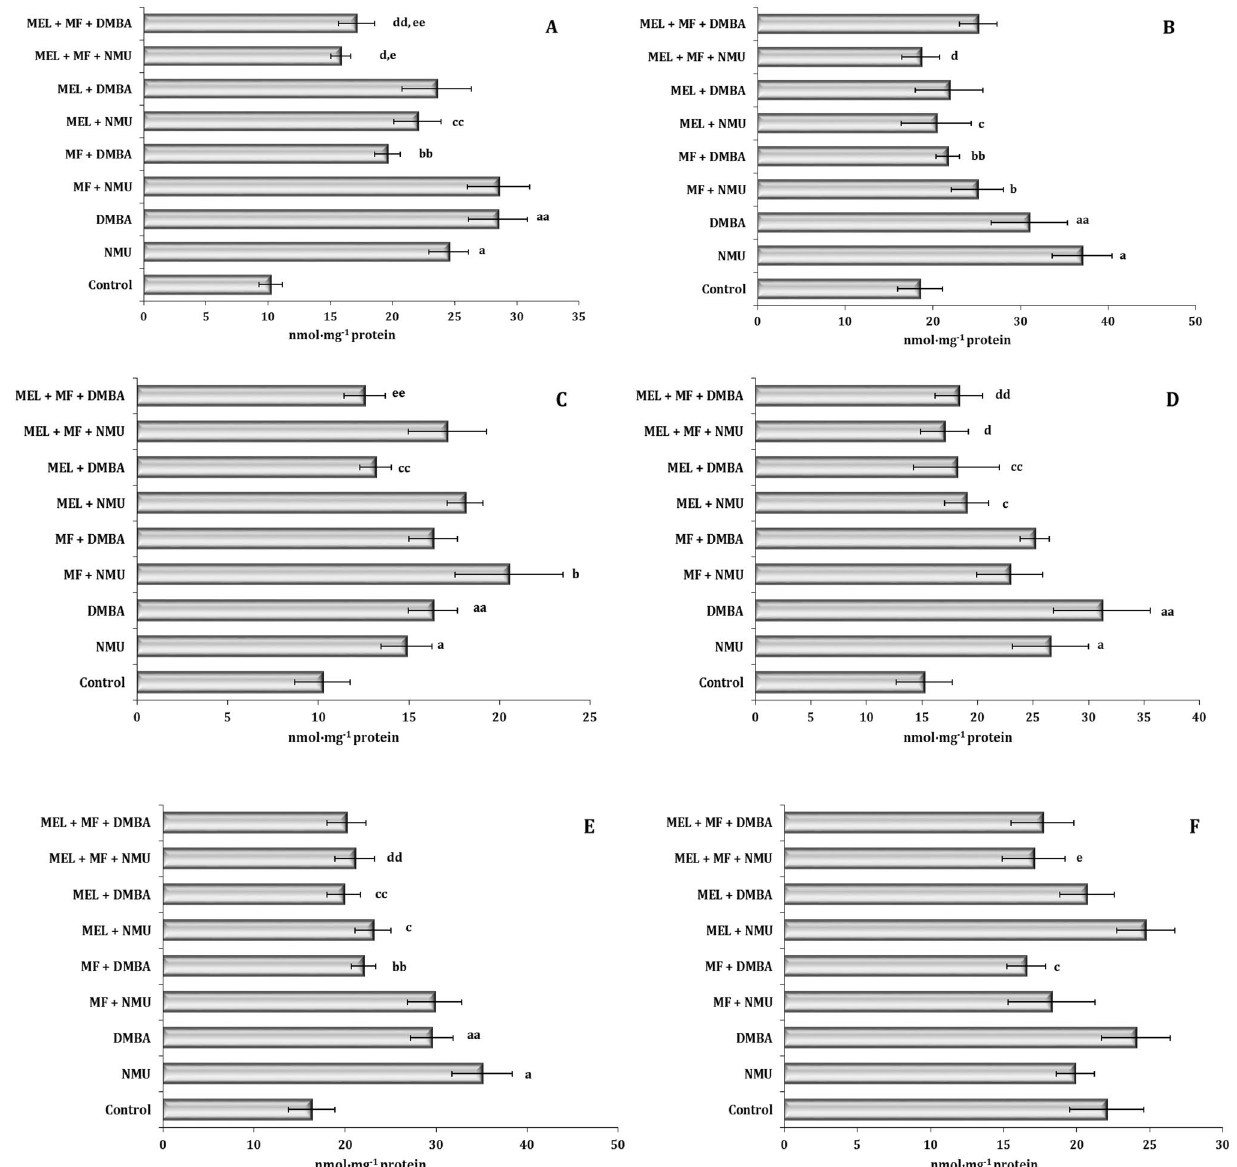
Figure 1. Content of conjugated dienes (A 233 , nmol mg −1 protein) in the liver ( A ), heart ( B ), spleen ( C ) and TBARS (nmol mg −1 protein) in the liver ( D ), heart ( E ), and spleen ( F ) of female Sprague–Dawley rats subjected to a high-fat diet in the mammary carcinogenesis model induced by N -methyl- N -nitrosourea (NMU) or dimethylbenzanthracene (DMBA). Metformin (MF) or melatonin (MEL) was administered alone and in combination (MF + MEL). Data are expressed as means ± S.D. Significant differences P < 0.05 are designated as follows: a—NMU group vs. control group; aa—DMBA group vs. control group; b—MF + NMU vs.